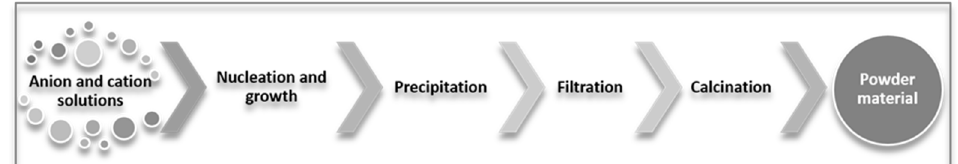
Figure 5. Synthesis scheme for the co-precipitation method.